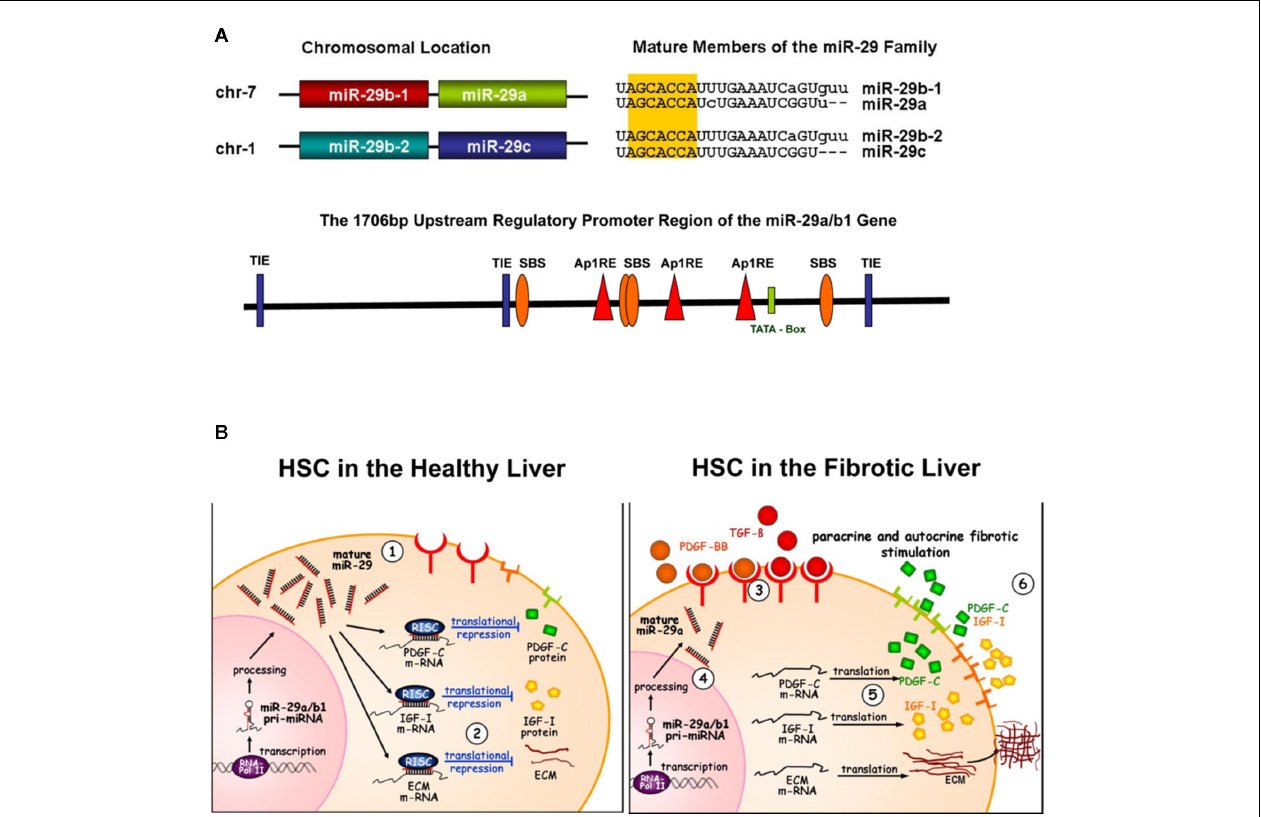
TGF- β by Smad and Ap1 signaling. (B) miR-29 signaling in the healthy and the fibrotic liver. In the healthy liver, mir-29 is highly expressed in hepatic stellate cells (1) and is responsible for repression of extracellular matrix proteins (ECM) in particular collagens (2), but also of expression of growth factors such as PDGF-C and IGF-I. During fibrogenesis, profibrogenic growth factors are increased and stimulate hepatic stellate cells in a paracrine and autocrine manner (3). Profibrogenic stimulation ofTGF- β and PDGF-BB results in miR-29 repression (4).The loss of miR-29 byTGF- β and PDGF-BB results in the abolished repression of profibrogenic expression of ECM, PDGF-C or IGF-I (5).The enhanced secretion of PDGF-C and IGF-I stimulates autocrinely stellate cells, leading to increased proliferation and ECM production